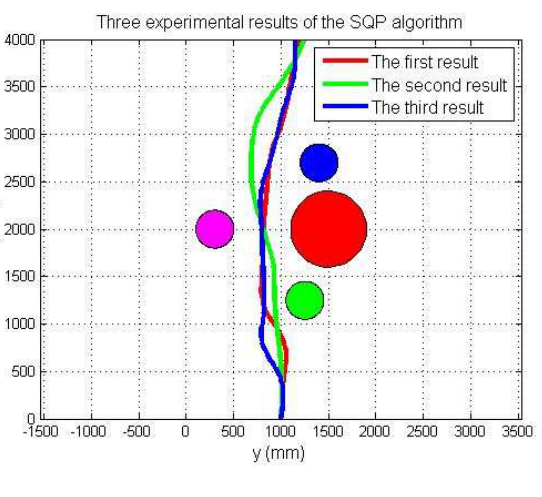
Figure 21. Motion deviation in the z-axis direction (the second experiment).